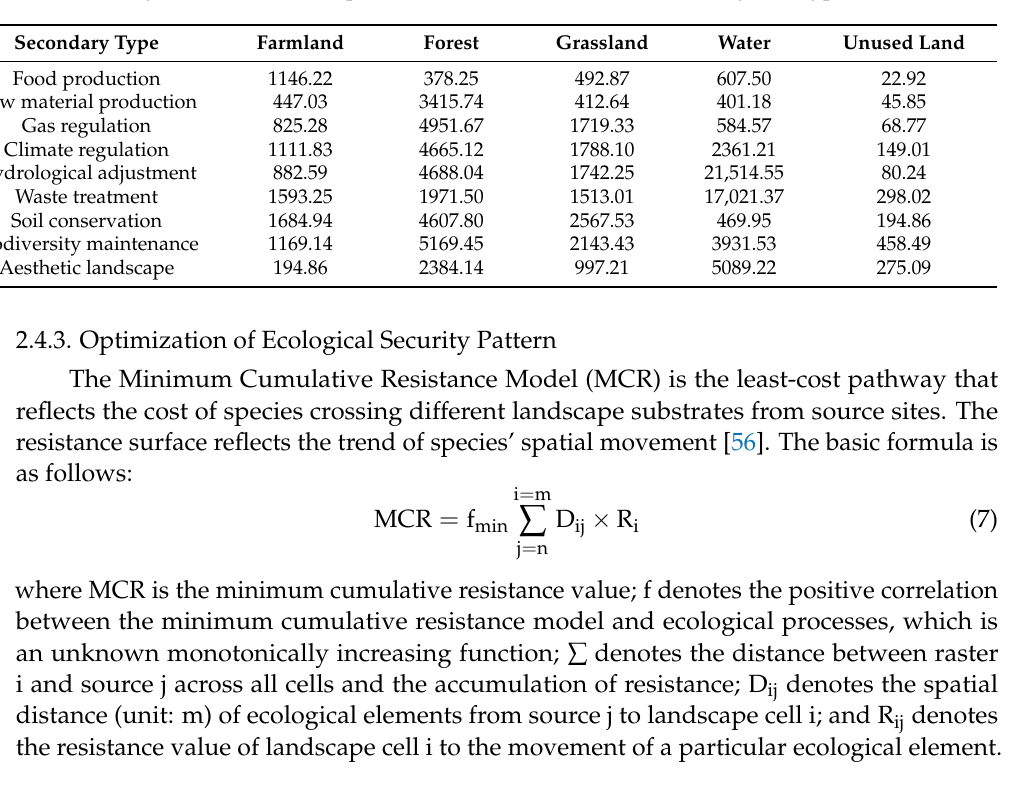
Table 1. Ecosystem service value per unit area of different terrestrial ecosystem types (CNY · hm − 2